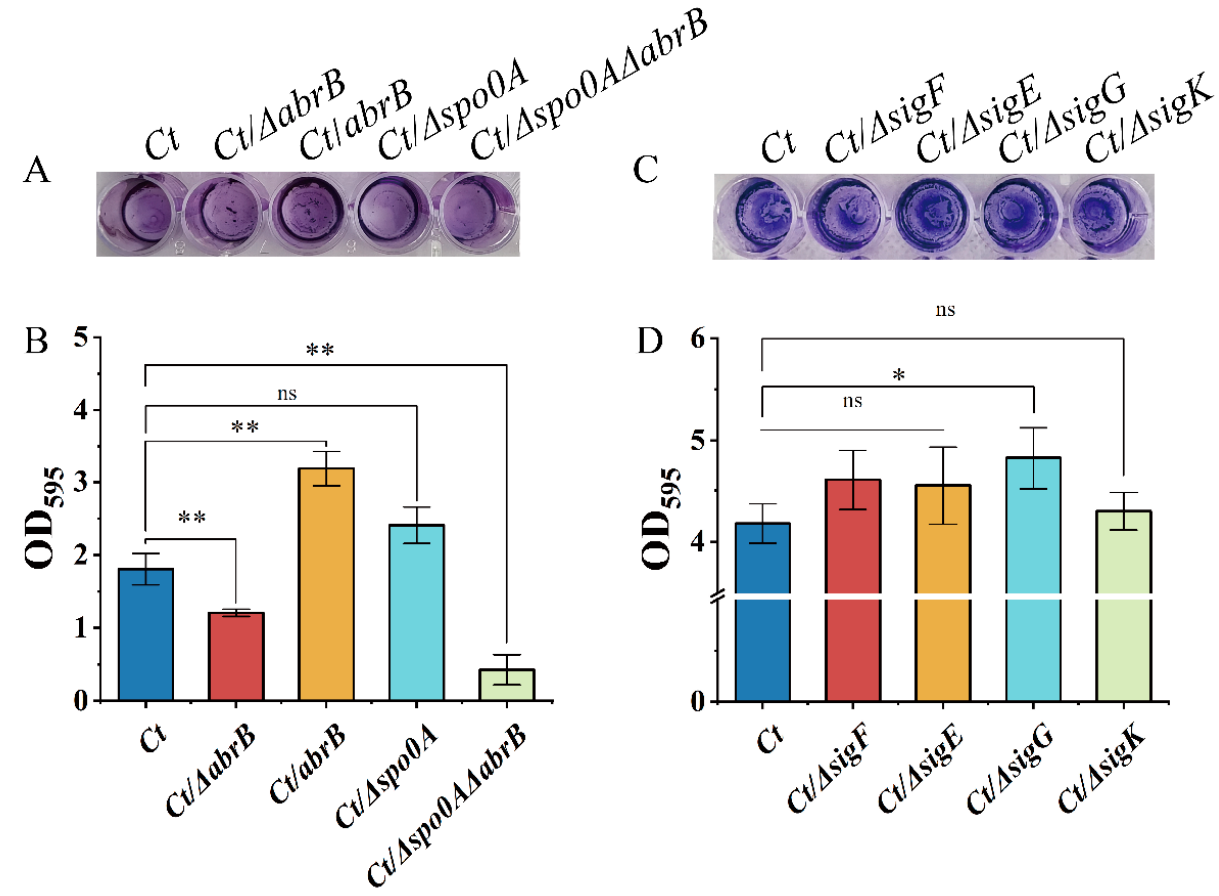
Figure 4. Multiple transcriptional regulators affect biofilm formation in C. tyrobutyricum. ( A ) Adhered biofilm formation of the abrB or spo0A mutants. The cells were cultured at 37 °C for 2 days and stained with crystal violet; ( B ) Quantification of the adhered biofilm biomass of abrB and spo0A mutants. ( C ) Adhered biofilm formation of the sigma mutants; ( D ) Quantification of the adhered biofilm biomass of the sigma mutants. Statistical significance was tested by one-way analysis of variance (ns, non-significant; *, p < 0.05 **, p < 0.01). The data are the means and standard deviations of three